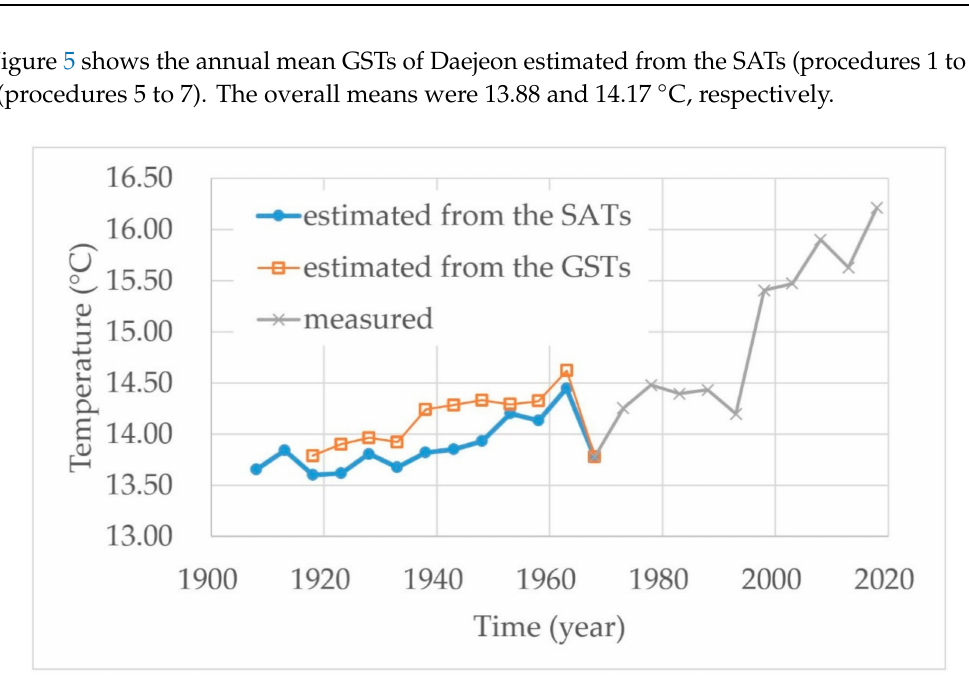
Figure 5. The annual mean GSTs of Daejeon used as the time-dependent upper boundary condition of the simulation model. Before 1969, the GSTs of Daejeon were estimated from the SATs of Daejeon (blue line) and the GSTs of other regions (orange line). They have been measured since 1969 (grey